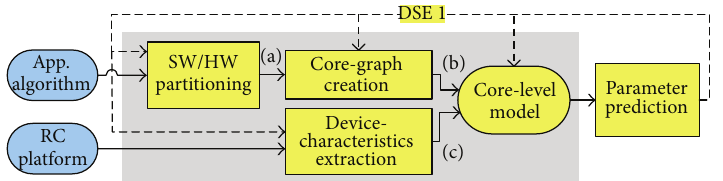
Figure 3: Core-level model construction with (a) FPGA tasks, (b) core graph, and (c) device